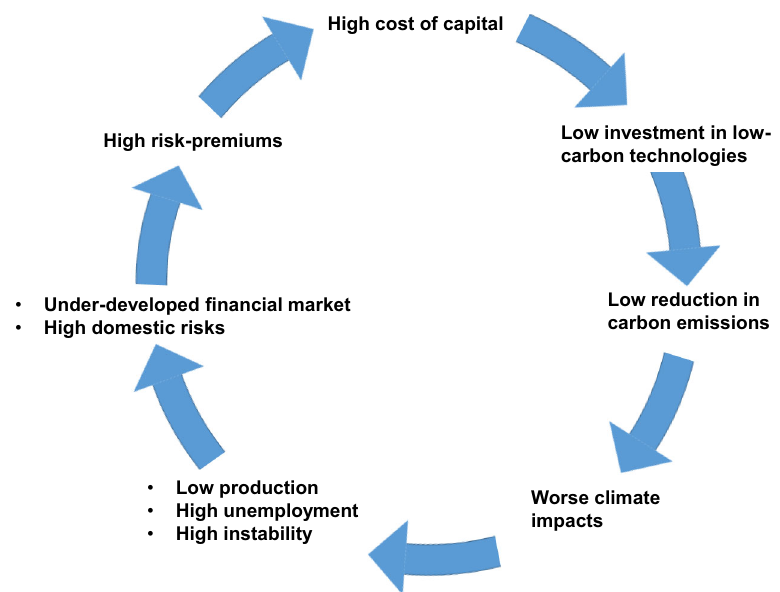
Fig. 1 The climate investment trap at the macroeconomic level. The fi gure shows the set of self-reinforcing mechanisms and related links occurring in developing economies characterised by the high cost of capital. The strength of these links is strongly linked to local conditions implying that the set of self- reinforcing mechanism could be exacerbated (or less relevant) in some economies.